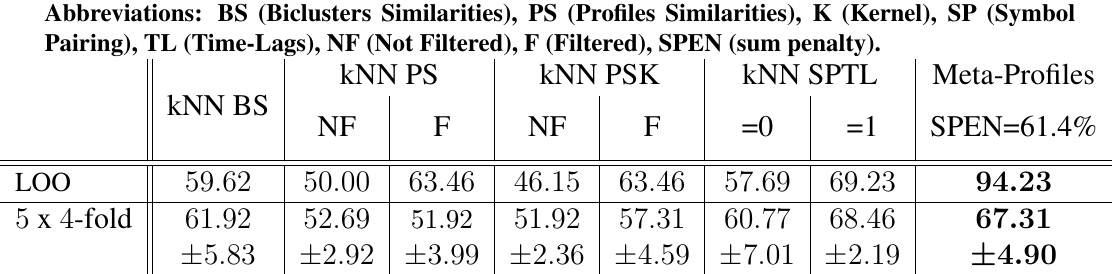
Table 1: Prediction accuracies for biclustering-based classifiers using LOO and 5 x 4-fold CV. Abbreviations: BS (Biclusters Similarities), PS (Profiles Similarities), K (Kernel), SP